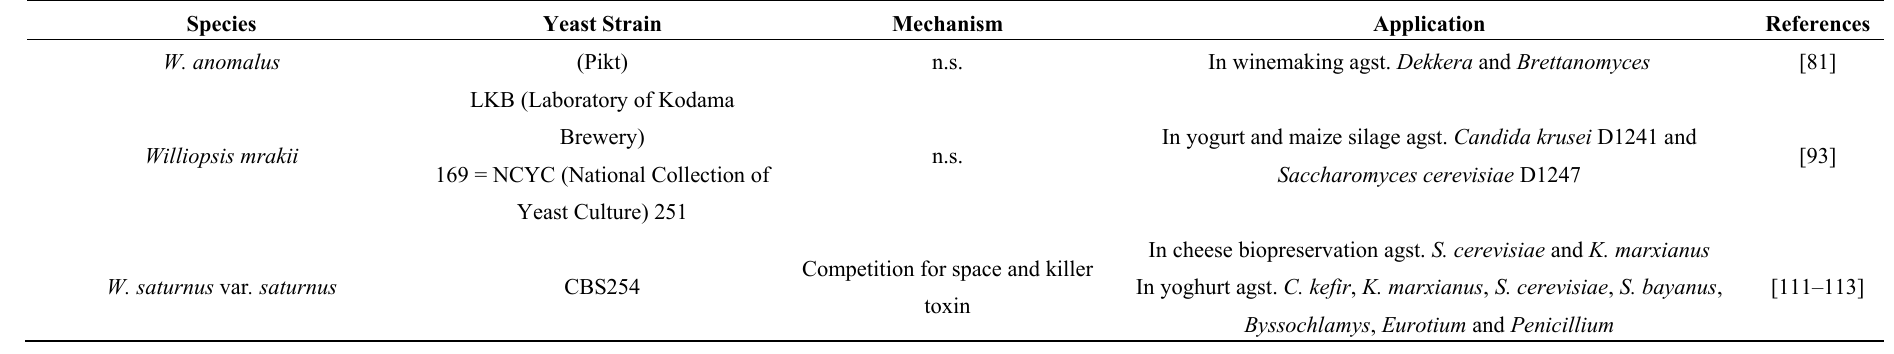
Table 2. Yeast strains, mechanism of action and applications against postharvest pathogenic molds on different commodities.